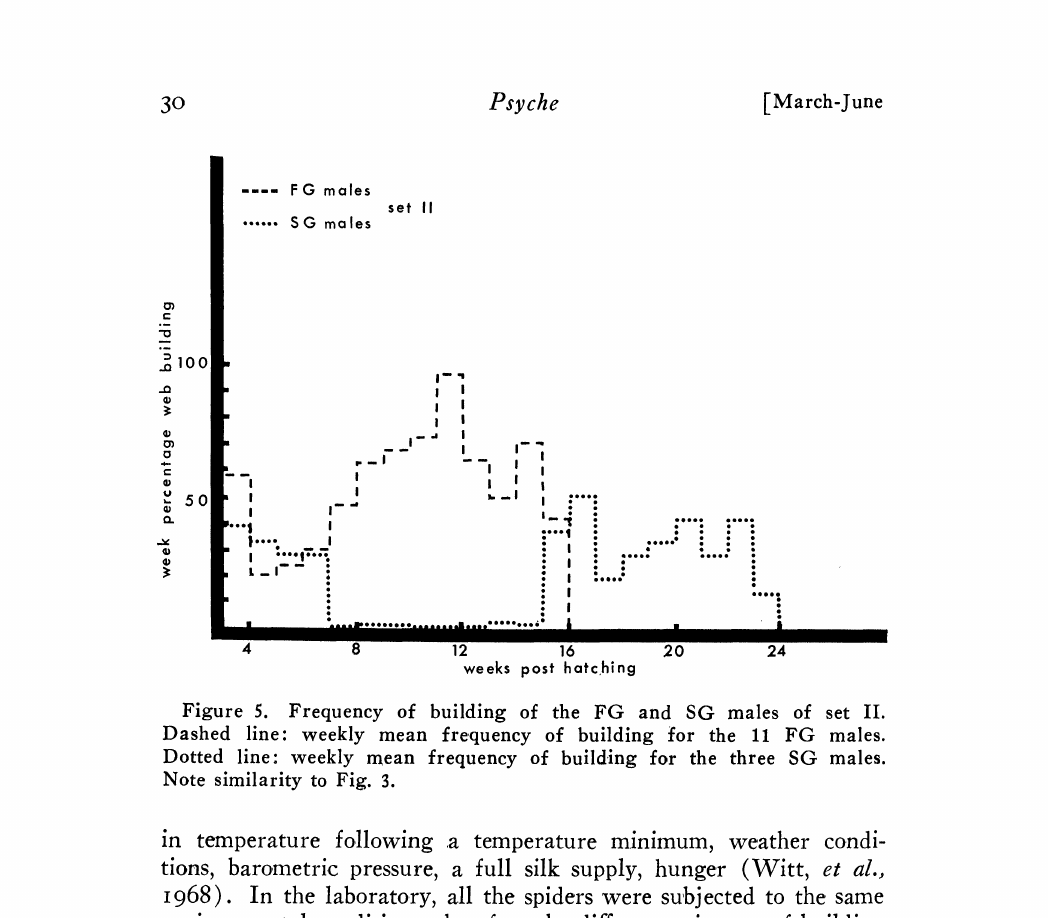
Figure 5. Frequency of building of the FG and SG males of set II. Dashed line: weekly mean frequency of building for the 11 FG males. Dotted line: weekly mean frequency of building fo,r the three SG males. Note similarity to Fig.